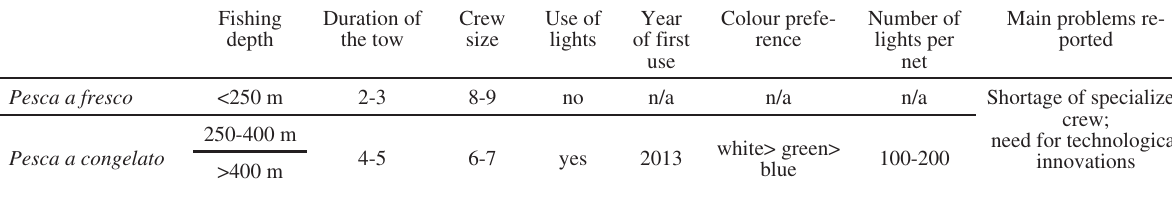
Table 4. – Use of LED lights as collected in the focus group